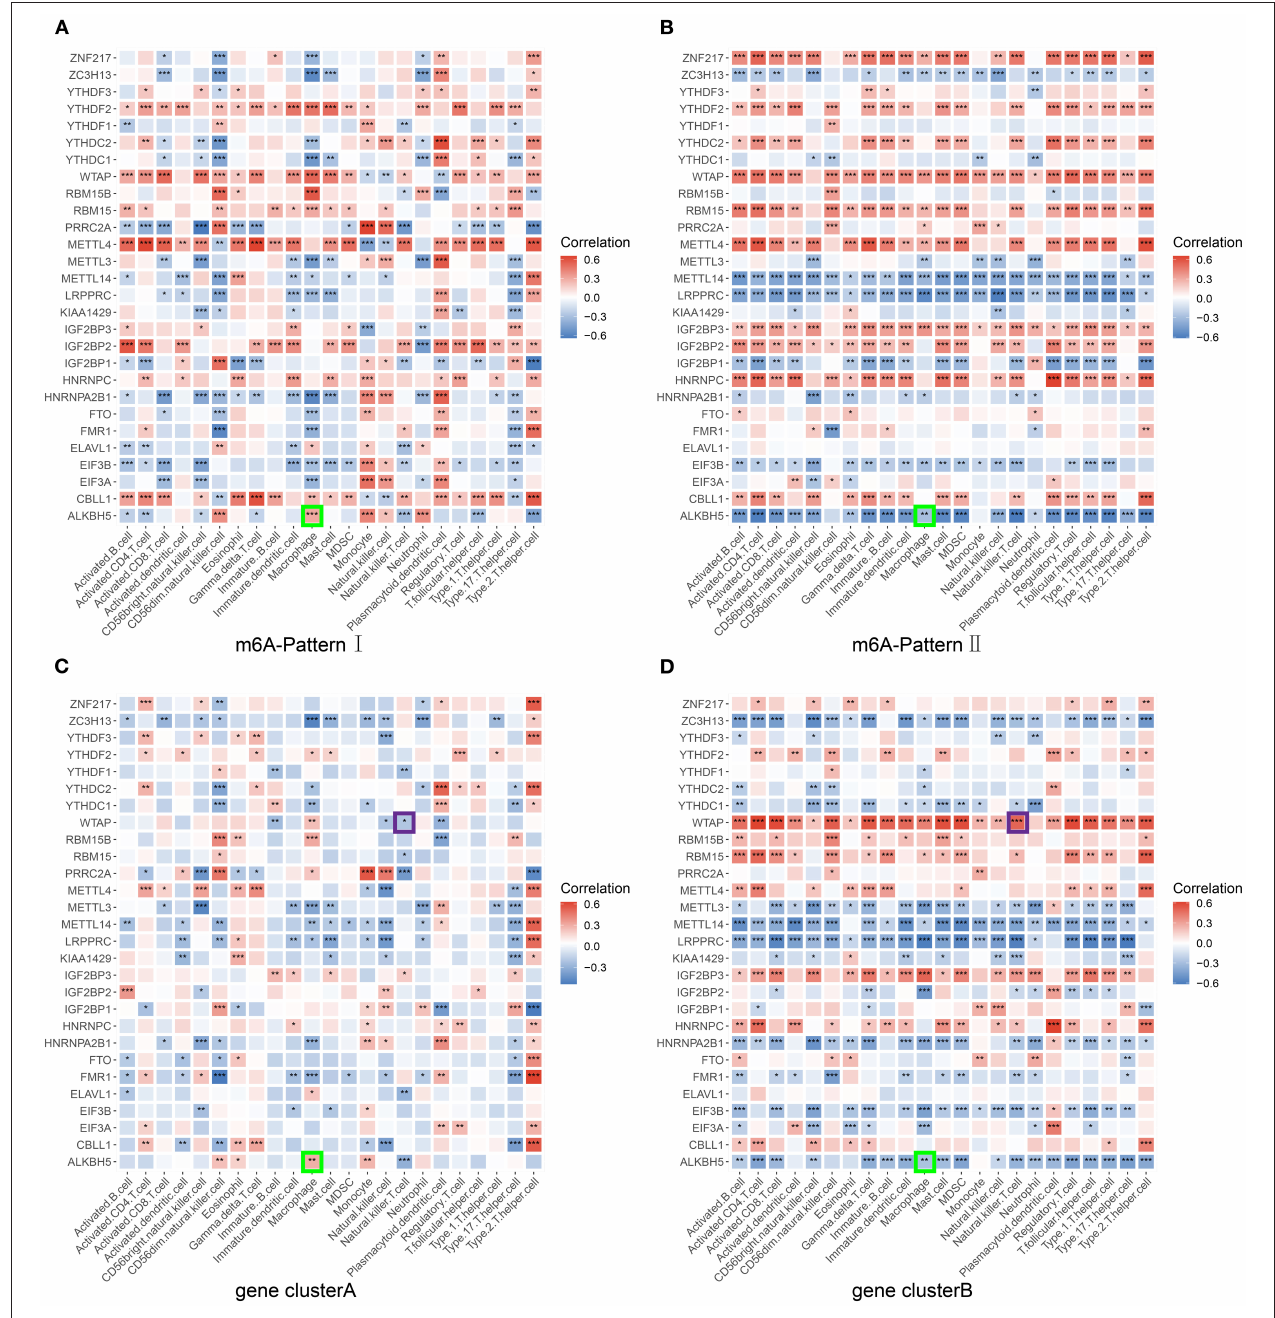
FIGURE 4 | Screening for critical genes and immune cells. The correlation between each infiltrating immune cell type and each m6A regulator was analyzed using Pearson’s correlation analyses and compared in different pairs of subgroups. (A) Patients of m6A-Pattern I. (B) Patients of m6A-Pattern II. (C) Patients of gene clusterA. (D) Patients of gene clusterB (*** p < 0.001; ** p < 0.01; * p <